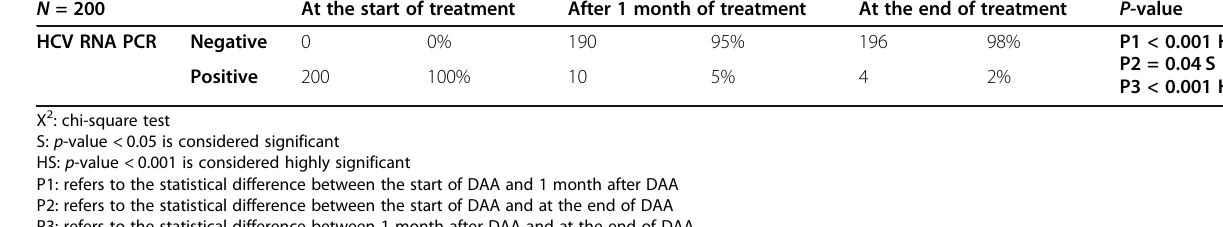
Table 1 Comparison between HCV RNA PCR results in the studied patients N = 200 At the start of treatment